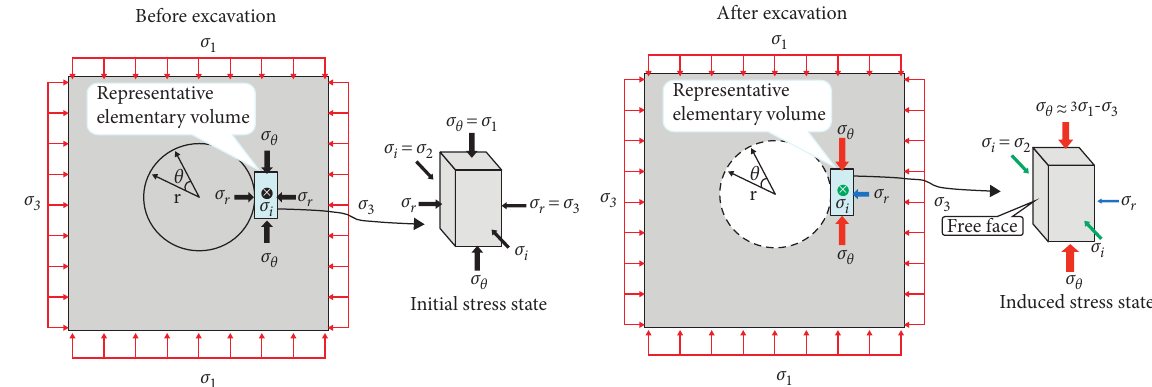
Figure 11: Schematic diagram of stress distribution on the tunnel wall before and after deep rock excavation [27].